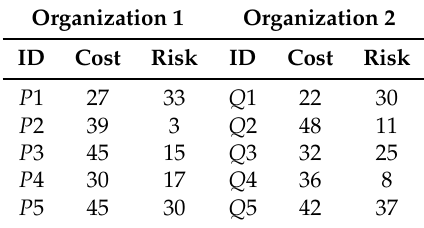
Table 1. Organization